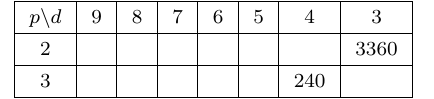
240 Table 33 . Number of E (6;2) -branes in the p -brane multiplet in d -dimensions [17]. p \ d 64 Table 34 . Number of E (7;7) -branes in the p -brane multiplet in d -dimensions. p \ d 2240 Table 35 . Number of E (7;4) -branes in the p -brane multiplet in d -dimensions. p \ d